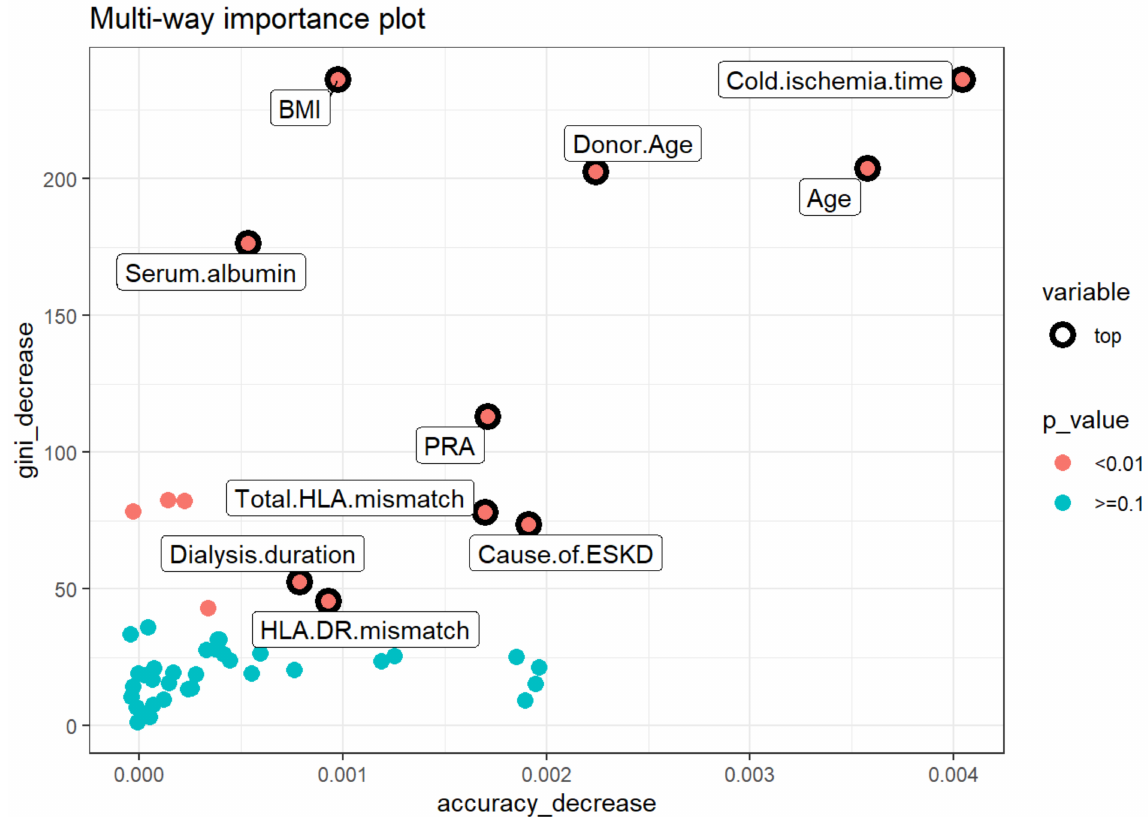
Figure 4. Multiway feature importance analysis of the acute rejection combining the mean decrease in Gini, decrease in accuracy, and p values of the features (pink circle; p < 0.01). Abbreviations: BMI—Body mass index; ESKD—End-stage kidney disease; HLA—Human leukocyte antigen; PRA—Panel reactive